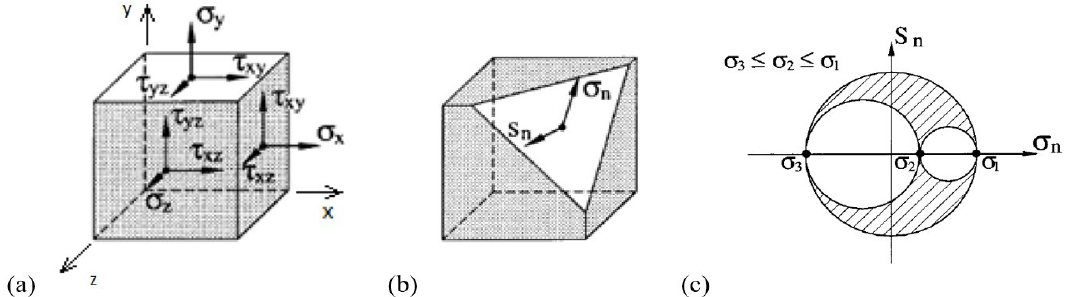
Figure 4. (a) Stress components in a solid element; (b) normal and shear stresses in an arbitrary plane; (c) Mohr circle for 3-D stresses in a point (adapted from Foster et al. [12])